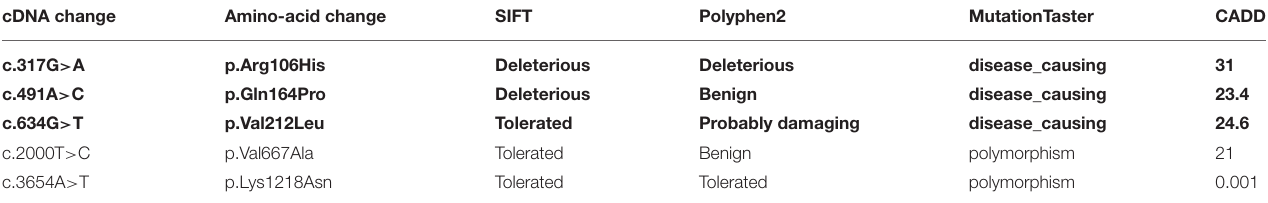
TABLE 2 | Results predicted by in silico tools of the missense variants which were present neither in control cohort nor in any of the population polymorphism databases. cDNA change